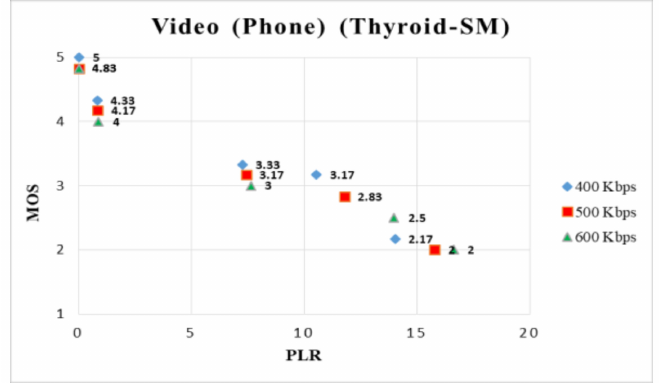
Figure 7. MOS ratings for thyroid ultrasound (SM) on